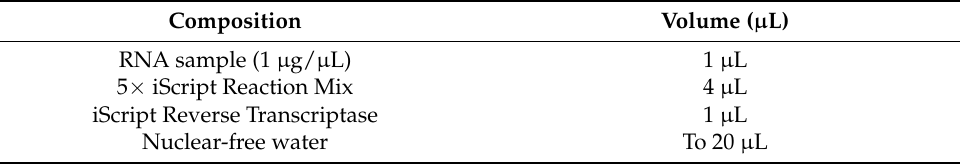
Table 1. Composition of the reaction